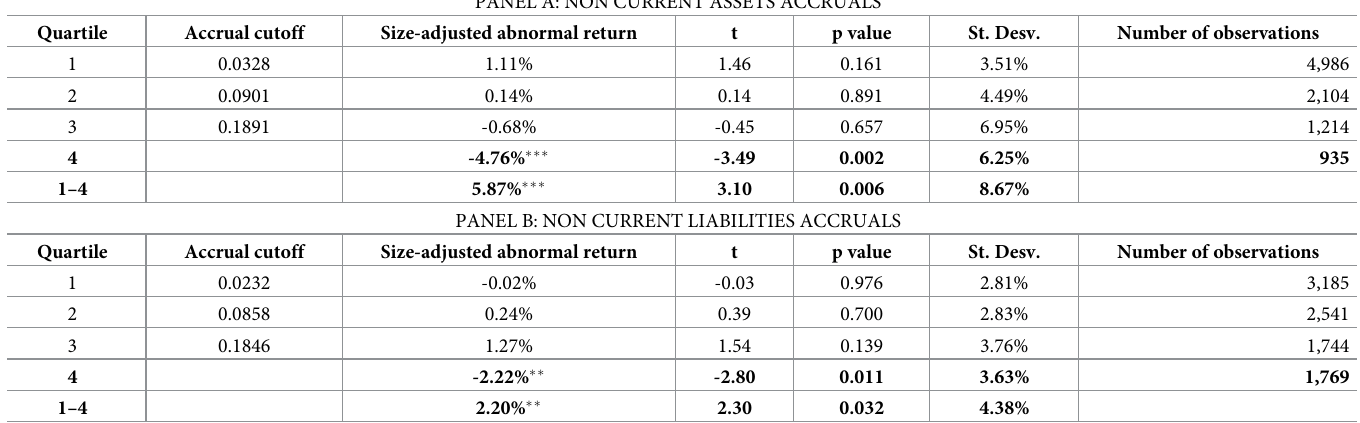
PANEL A: NON CURRENT ASSETS